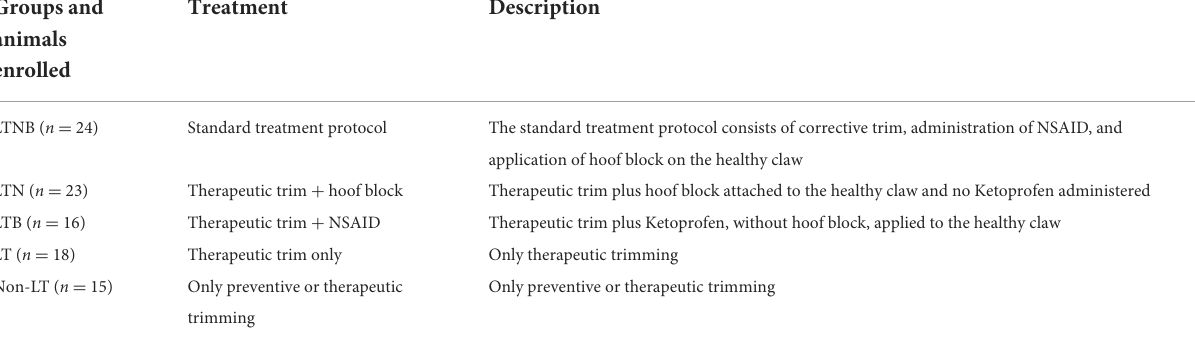
TABLE 2 Experimental groups and treatments administered in the randomized clinical